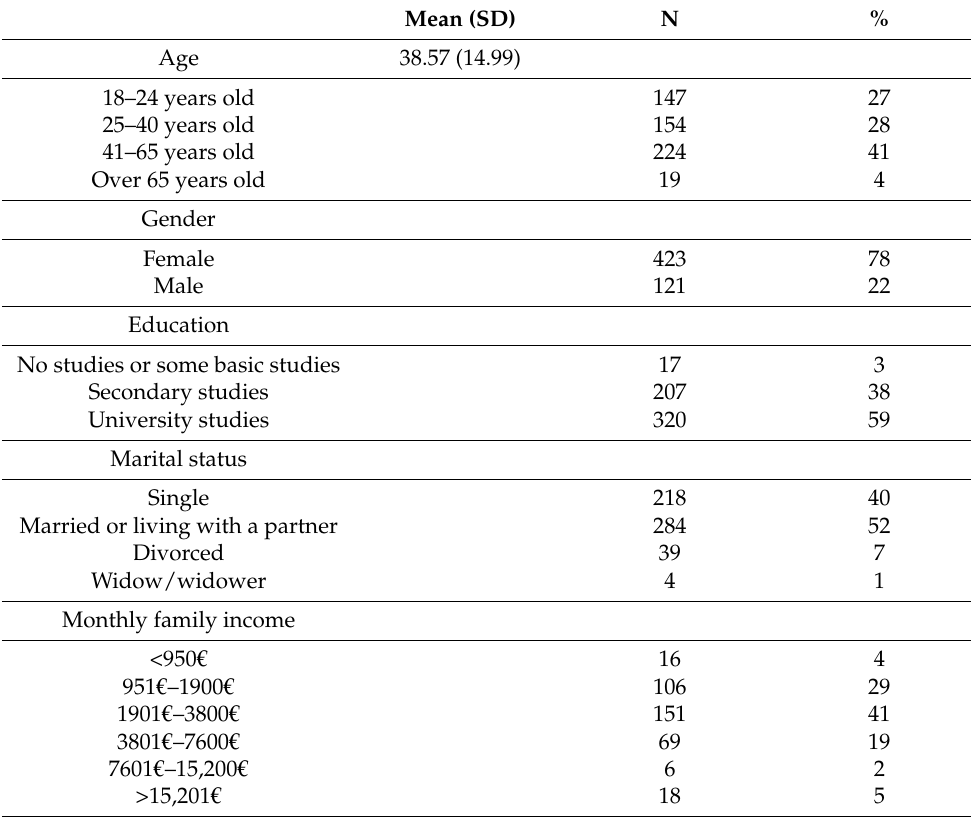
Table 1. Descriptive data for the study sample (N =